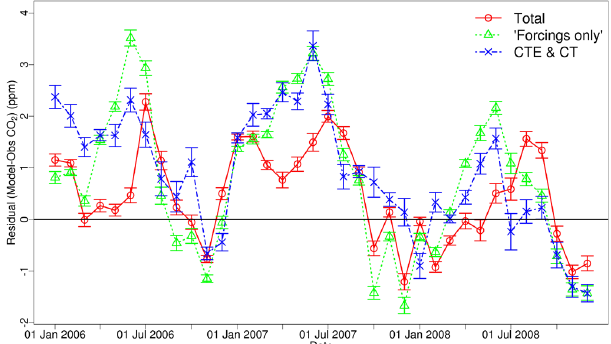
Fig. 4. Monthly mean mixing ratios for net uptake and net release CO 2 tracers for crop and forest ecosystems simulated at TTA. High- lights differences in detection of ecosystem processes at TTA, in particular the distinct seasonal cycle of cropland net uptake and net release CO 2 tracers compared to all other ecosystems. Man- aged grassland and “other” ecosystems are not included due to their small magnitude contributions, never exceeding